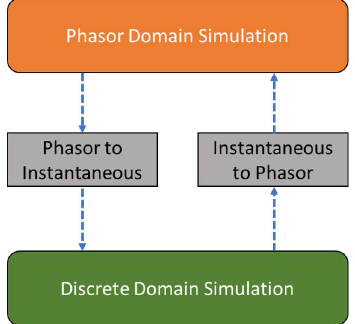
Figure 3. Data exchange during hybrid simulation between two different simulation